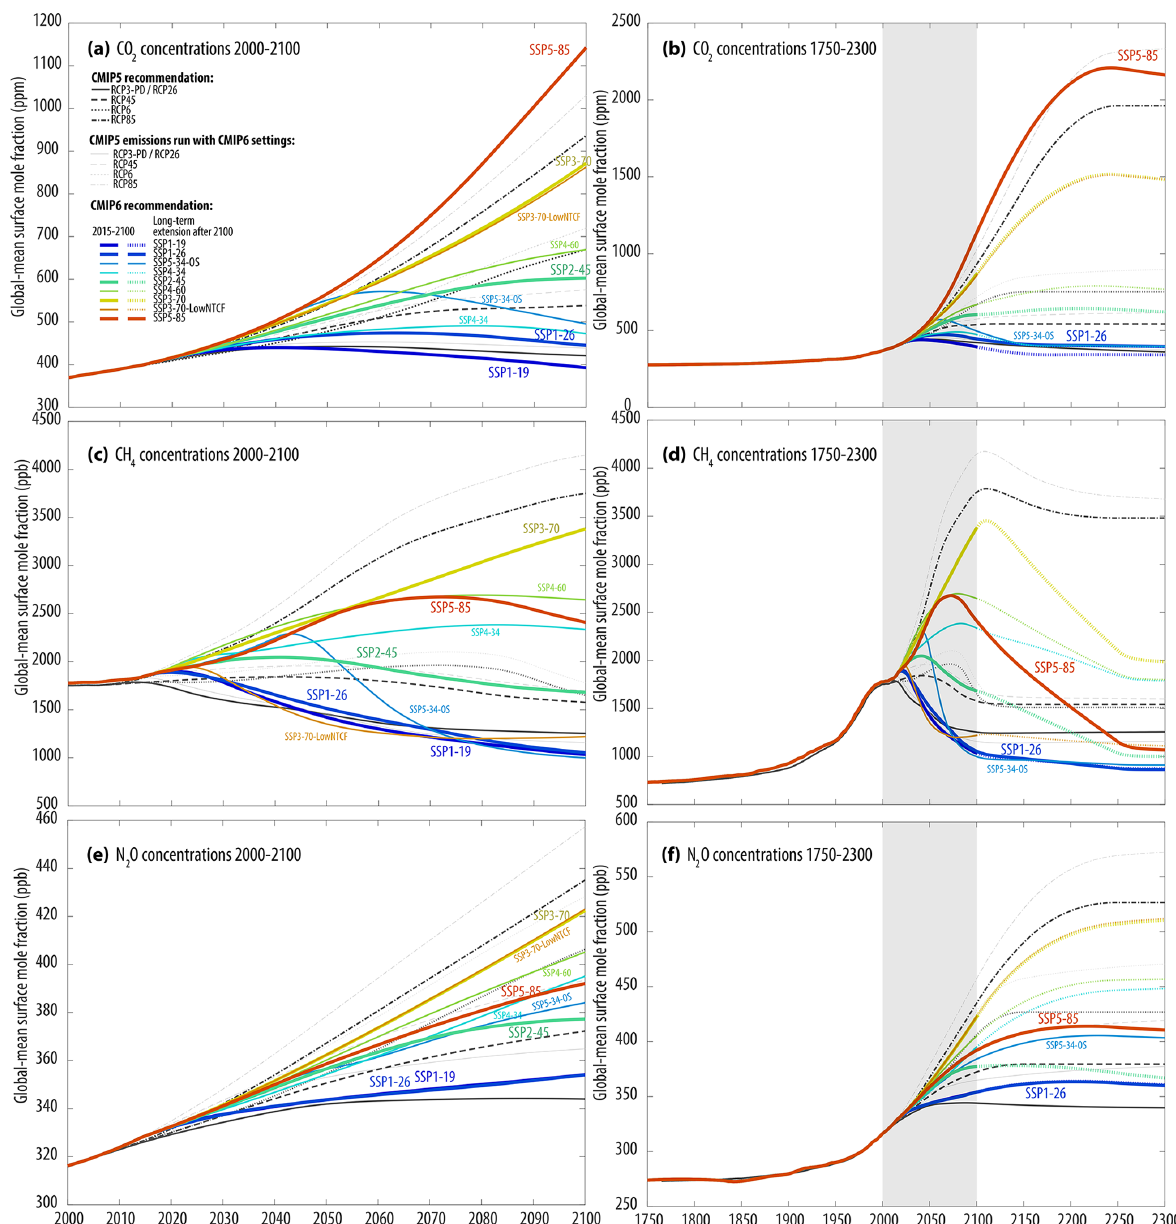
Figure 11. Overview of SSP concentrations in comparison with RCP concentrations for CO 2 , CH 4 , and N 2 O. The original RCP scenarios are shown in thicker black lines and various line styles. Applying the new MAGICC7 default setting used for the SSP scenarios to the RCP emissions results in generally higher concentrations (grey